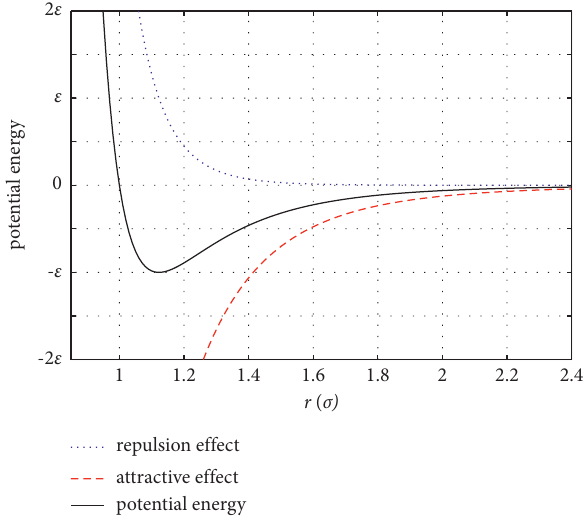
Figure 4: Lennard–Jones potential